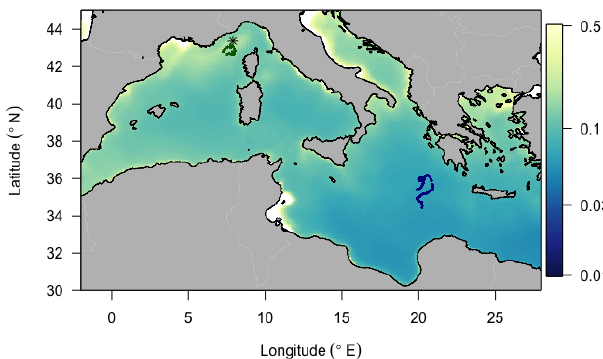
Figure 1. Trajectories of the two BGC-Argo profiling floats fLig (WMO: 6901776) and fIon (WMO: 6902828) deployed, respec- tively, in the Ligurian Sea (green) and the Ionian Sea (blue), su- perimposed onto a 9km resolution summer climatology of sur- face chlorophyll a concentration (in mgm − 3 ) derived from MODIS Aqua ocean color measurements. The asterisk-shaped symbol indi- cates the geographic location of the BOUSSOLE